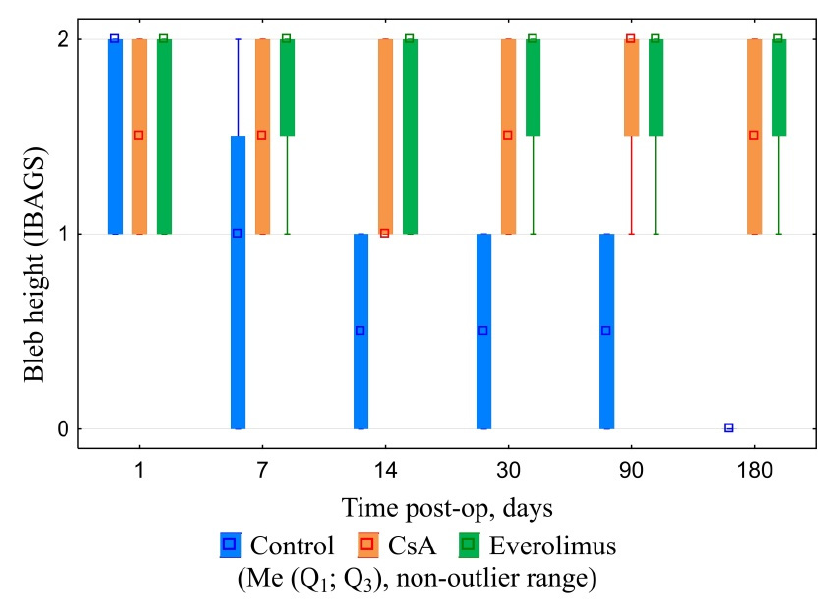
Figure 9. Blebs’ height Figure 9 . Blebs’ height dynamics .